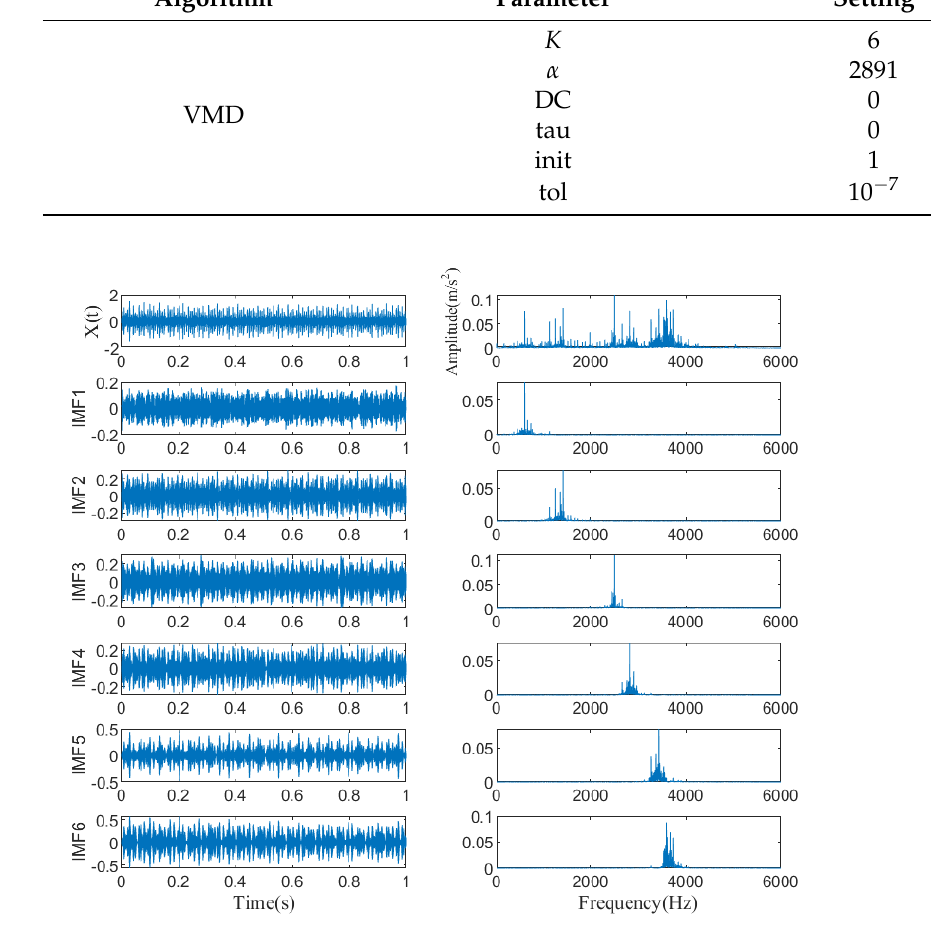
Figure 3. Time-domain waveform and frequency spectrum of original signal and IMFs for inner race signal by VMD ( K = 6, α =